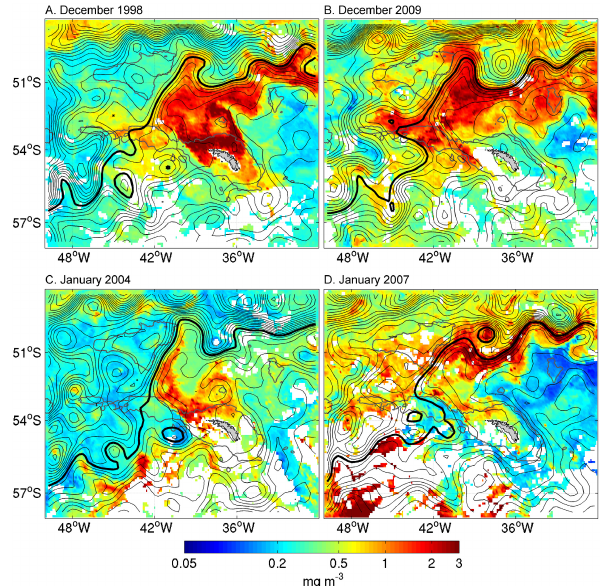
Fig. 4. Monthly composites of Chl a concentrations (colour) and concomitant dynamic topography isopleths (black lines) for (A) De- cember 1998, (B) December 2009, (C) January 2004 and (D) Jan- uary 2007, respectively. Isopleths are equally spaced every 5 dyn cm to highlight the smaller scale features; values decrease from north to south. As reference, the − 71dyncm contour is depicted with a bold line, to indicate, according to Venables et al. (2012), the south- ern limit of the Polar Front. Colour scale units aremgm − 3 . Yellow to red colours depict bloom conditions (Chl a ≥ 0.75mgm − 3 ) . Re- gions in white correspond to data gaps due to the presence of per- sistent cloud cover. For reference, the 2000m bathymetry contour is also indicated with thin grey